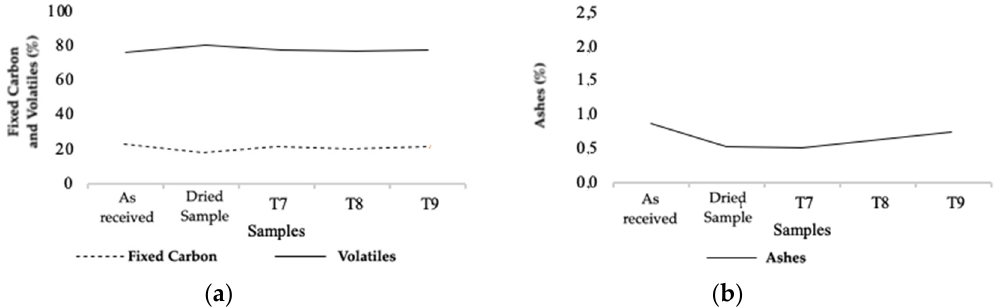
torrefied samples of Series 2.